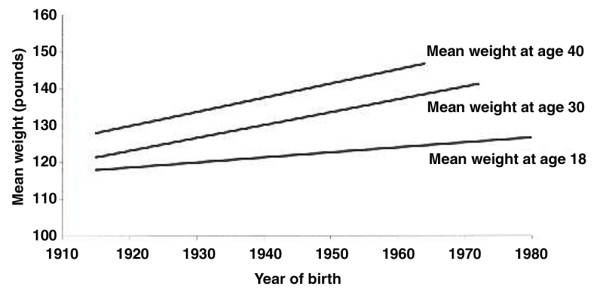
Weight at various ages among BRCA mutation carriers according to year of birth.